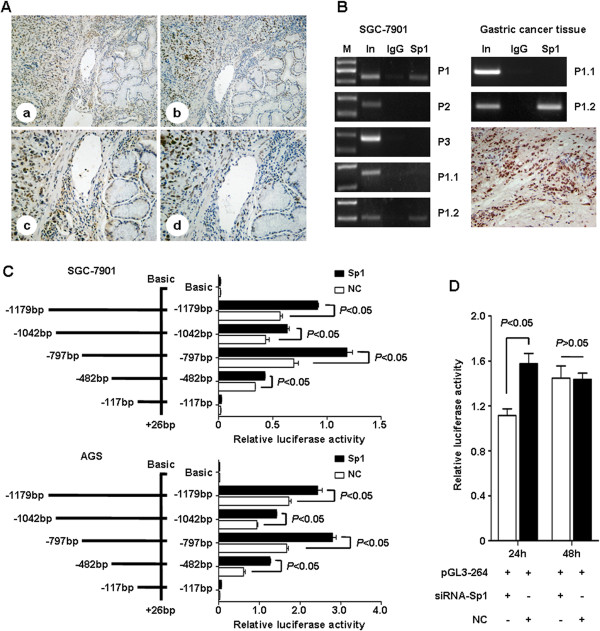
Sp1 enhance transcriptional activity of human MTA2 gene promoter. A, Expression of MTA2 (a × 100, c × 200) and Sp1 (b × 100, d × 200) in gastric cancer tissues were detected by IHC. B, DNA fragment pulled down with Sp1 antibody from SGC-7901 cells was amplified by PCR using P1 (-1179 bp ~ -843 bp), P2 (-948 bp ~ -671 bp), P3 (-559 bp ~ -301 bp), P1.1 (-1179 bp ~ -1023 bp) and P1.2 (-1043 bp ~ -843 bp). P1.1 (-1179 bp ~ -1023 bp) and P1.2 (-1043 bp ~ -843 bp) were used for gastric cancer tissue with Sp1 high expression. C, Luciferase reporters containing five different length of MTA2 promoter were co-transfected with Sp1 plasmid into SGC-7901 and AGS cells. Relative luciferase activity was detected, respectively. D, pGL3-264 luciferase reporter was co-transfected with siRNA-Sp1 into SGC-7901 cells, and relative luciferase activity was detected. M: Marker; In: Input; P: Primer; NC: negative control.